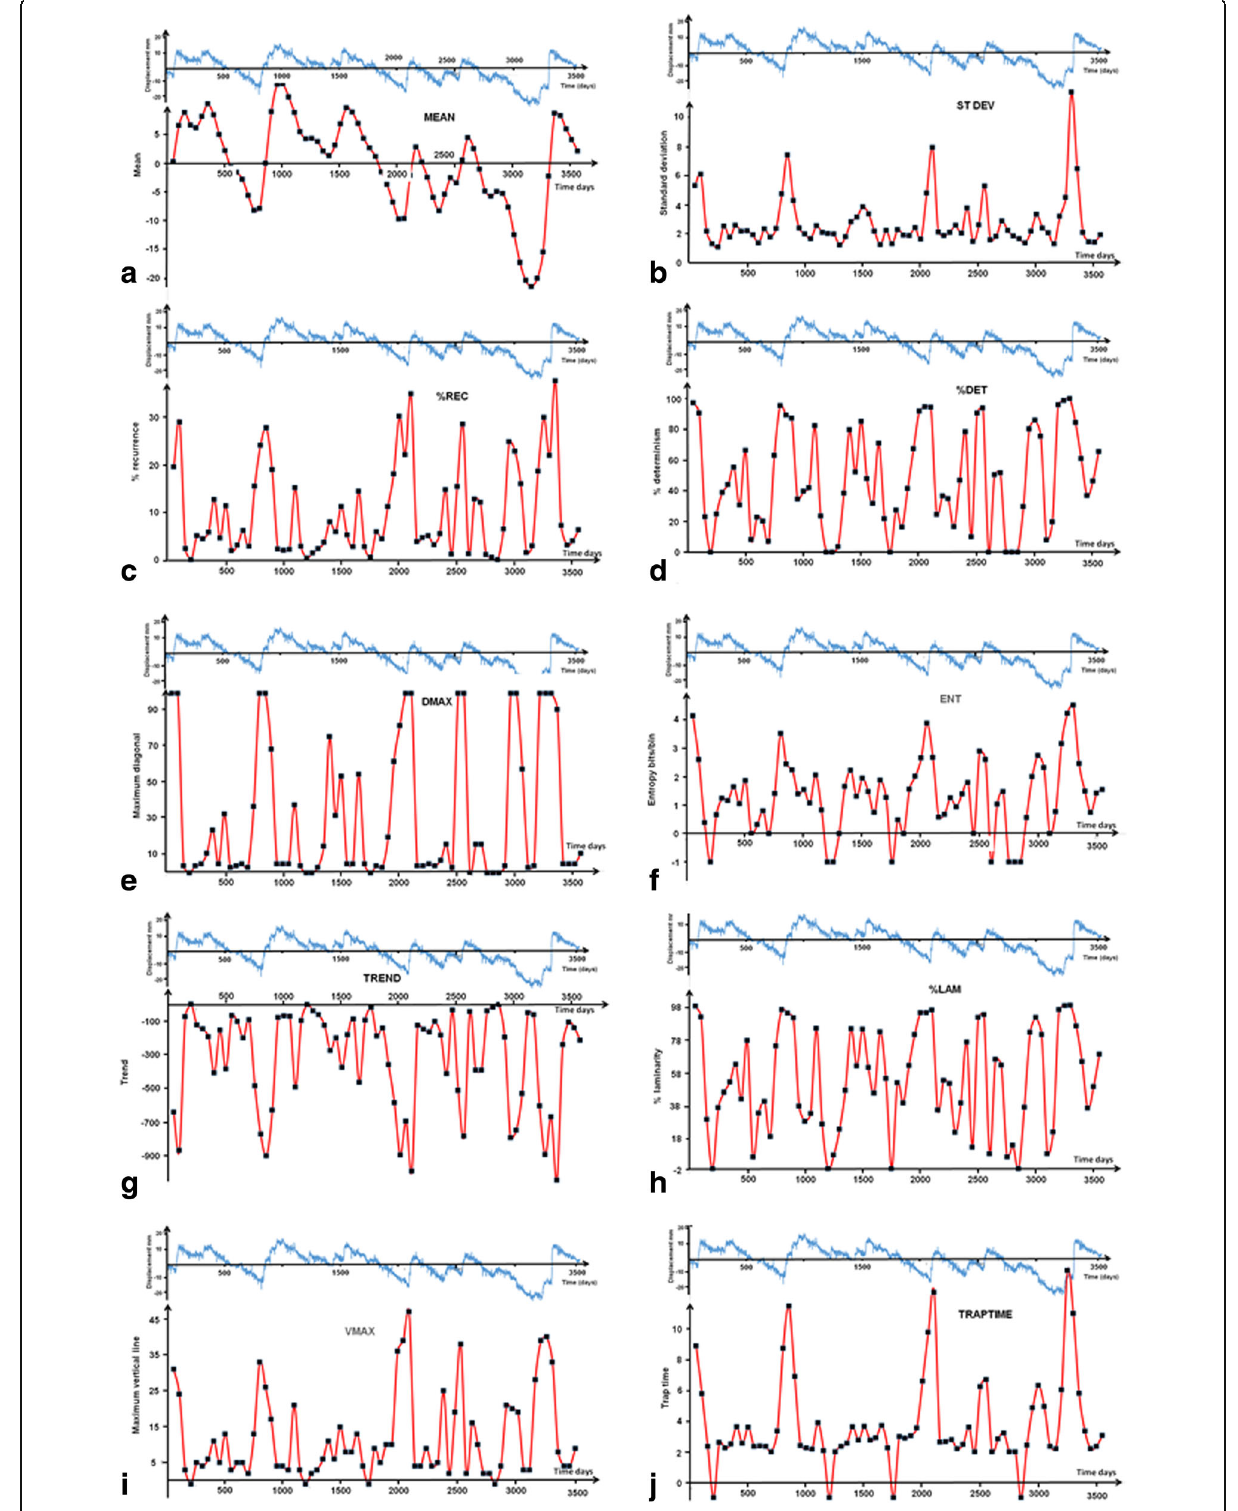
Fig. 16 RQA measures for a sliding window of width 100 days and an overlap beween windows of 50 days for the data set CNST_e shown at the top of each frame. a Mean. b Standard deviation. c %REC. d %DET. e DMAX. f ENT. g TREND. h %LAM. i VMAX. j